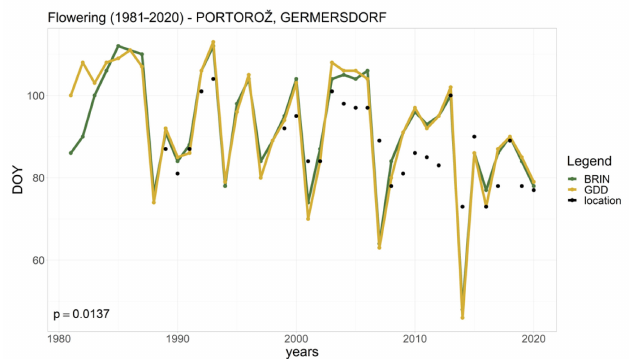
Figure 4. Modeled and observed budburst dates of the Germersdorf sweet cherry variety in Portorož, with the sub-Mediterranean climate type. Yellow lines indicate results obtained with GDD, green lines indicate results obtained with BRIN, and black dots indicate the observed budburst date according to the Slovenian Environment Agency dataset. Added is the statistical significance ( p ) of the trend in observed budburst dates, calculated with the Mann–Kendall test, and day of year is denoted as DOY.